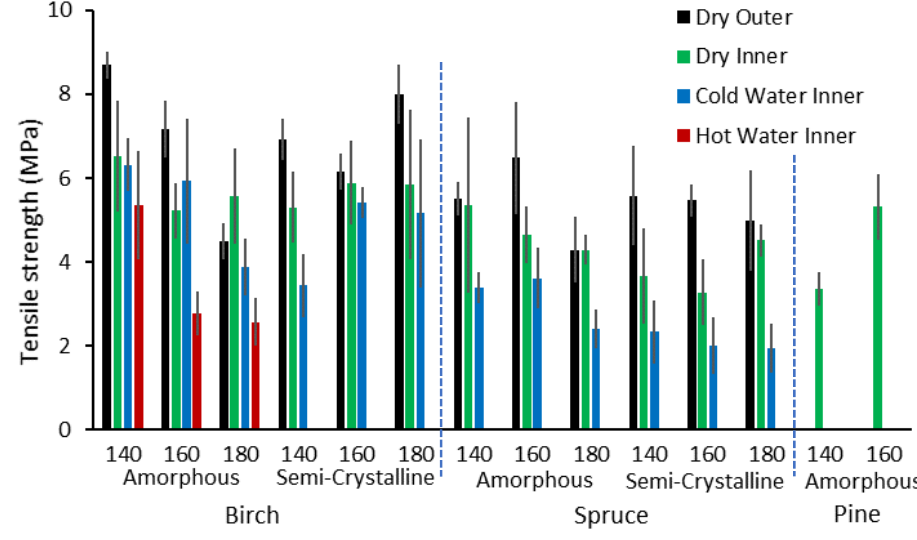
Figure 3. Comparison of tensile bondline strength for laminated panel samples tested dry and after 24 h of cold water or 6 h of hot water soaking.